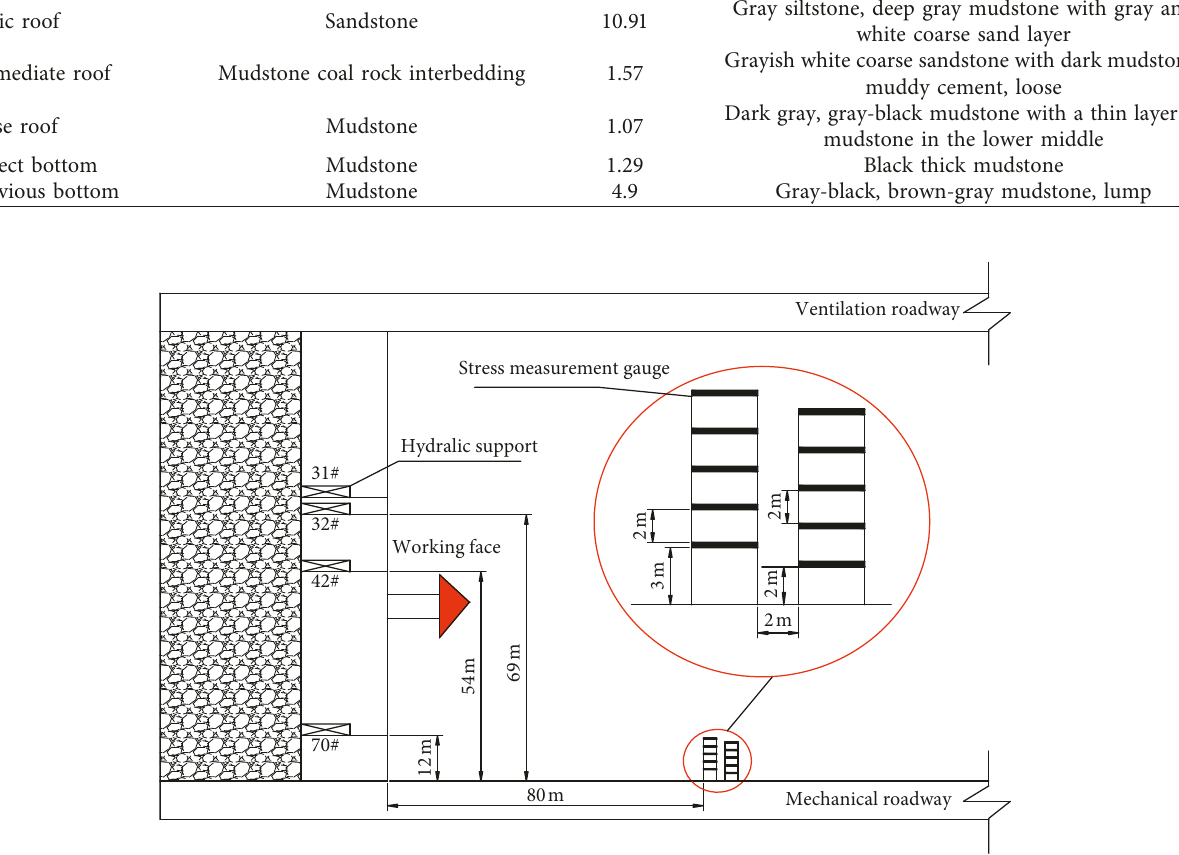
Figure 21: Drilling stress measurement point layout and measuring point layout.